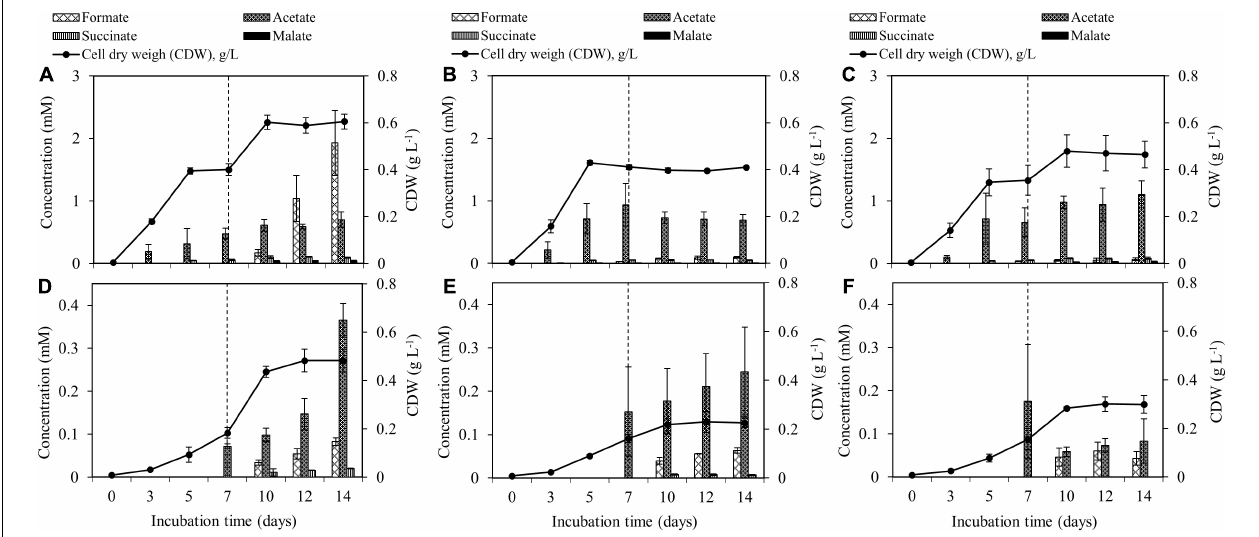
FIGURE 3 | Accumulation of organic acid production and biomass production during the 14-day incubation of M. tundripaludum SV96 (A–C) and M. rosea SV97 (D–F) under three different gas supplementation schemes applied on day 7: (test I) both CH 4 and air added (A,D) , (test II) only CH 4 added (B,E) , and (test III) only air added (C,F) . Error bars indicate the standard deviation of triplicate